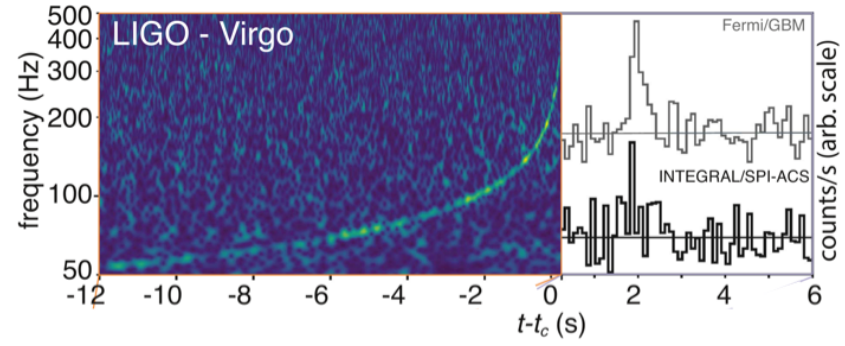
Figure 8. Timeline of the GRB 170817A/GW170817 event [34]. ( c (cid:13) AAS. Reproduced with permission.)